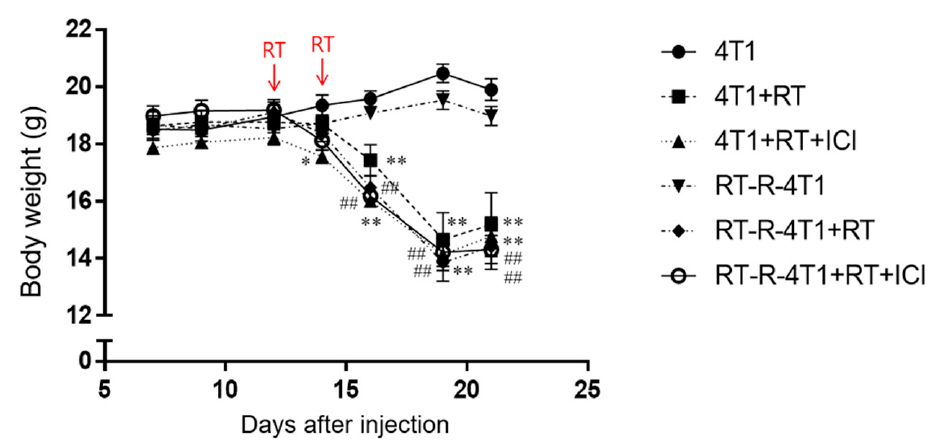
Figure 4. Combined PD-1 blockade therapy and RT showed side effects in the body weights of mice. From day 7 after 4T1 or RT-R-4T1 cancer cell inoculation (n = 4–6), the body weight of mice was measured 3 times a week during tumor development. Arrows indicate the points at which RT was delivered. * p < 0.05, ** p < 0.01 compared to the 4T1-injected group; ## p < 0.01 compared to the RT-R-4T1-injected group.